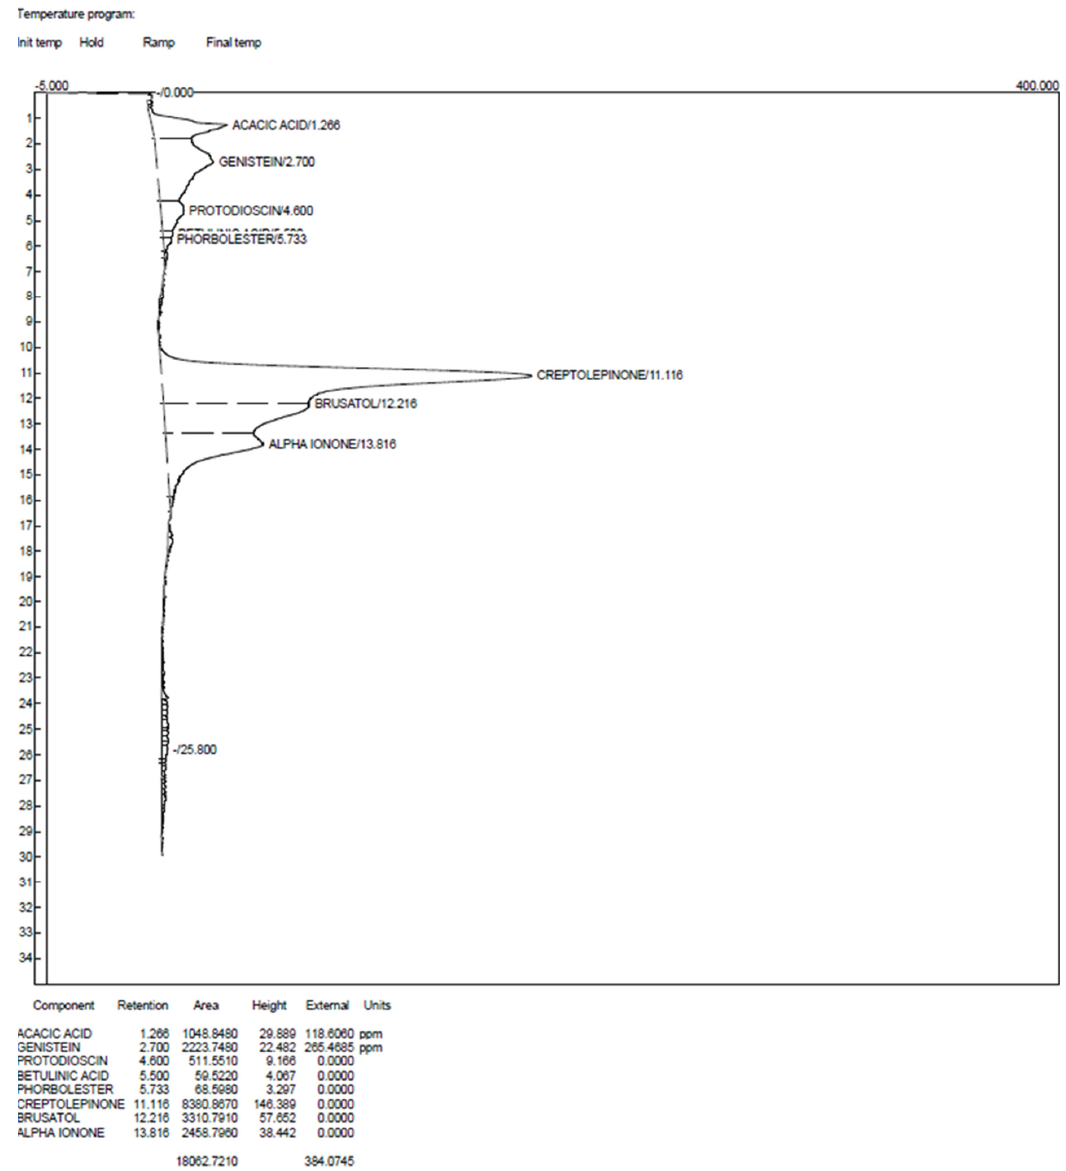
Figure 8. Chromatogram of acetone extract of C. papaya